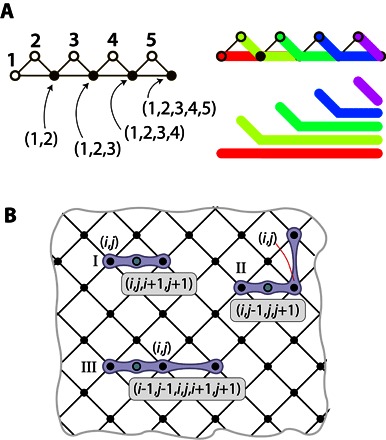
Lattices with higher-order interactions.(A and B) Methods for representing multibody interactions. In (A), this is achieved by a ladder of stabilizers; on the left figure, filled circles represent increasingly high-order correlations. The top right figure shows how the chains of logical x operators intersect, whereas the bottom right figure shows, for clarity, the same chains but without overlapping. In (B), the lattice notation follows that of Fig. 1A. Green circles denote additional physical spins representing multibody interactions. Purple links denote stabilizers. In case I, the stabilizer of physical spins (i, j) and (i + 1, j + 1) and of the additional physical spin corresponds to the four-body term σiZLZjσi+1Zσj+1Z; in case II, the stabilizer of physical spins (i − 1, j − 1), (i, j), and (i − 1, j + 1) and of the additional physical spin corresponds to the four-body term σiZσj−1ZσjZσj+1Z; and in case III, the stabilizer of physical spins (i − 1, j − 1), (i, j), and (i + 1, j + 1) and of the additional physical spin corresponds to the six-body term σi−1Zσj−1ZσiZσjZσi+1Zσj+1Z.